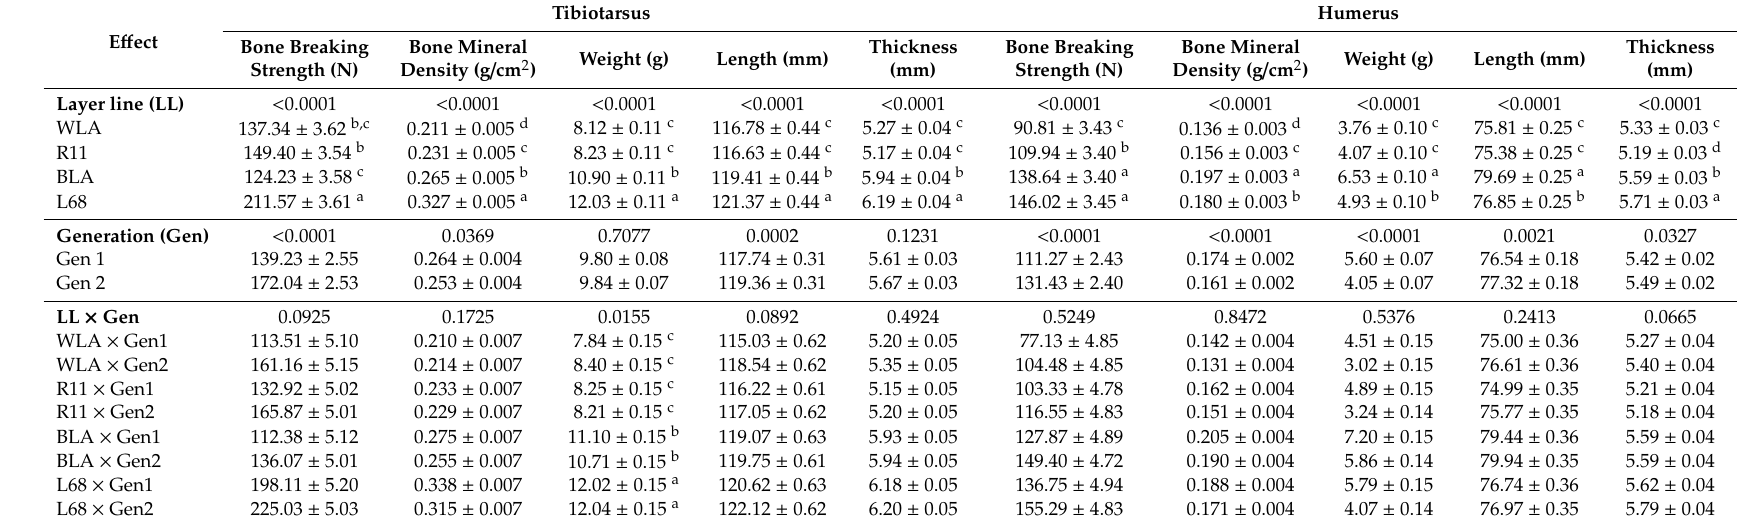
a,b,c,d Means with di ff erent letters within an e ff ect di ff er significantly (Tukey’s HSD-test, p <